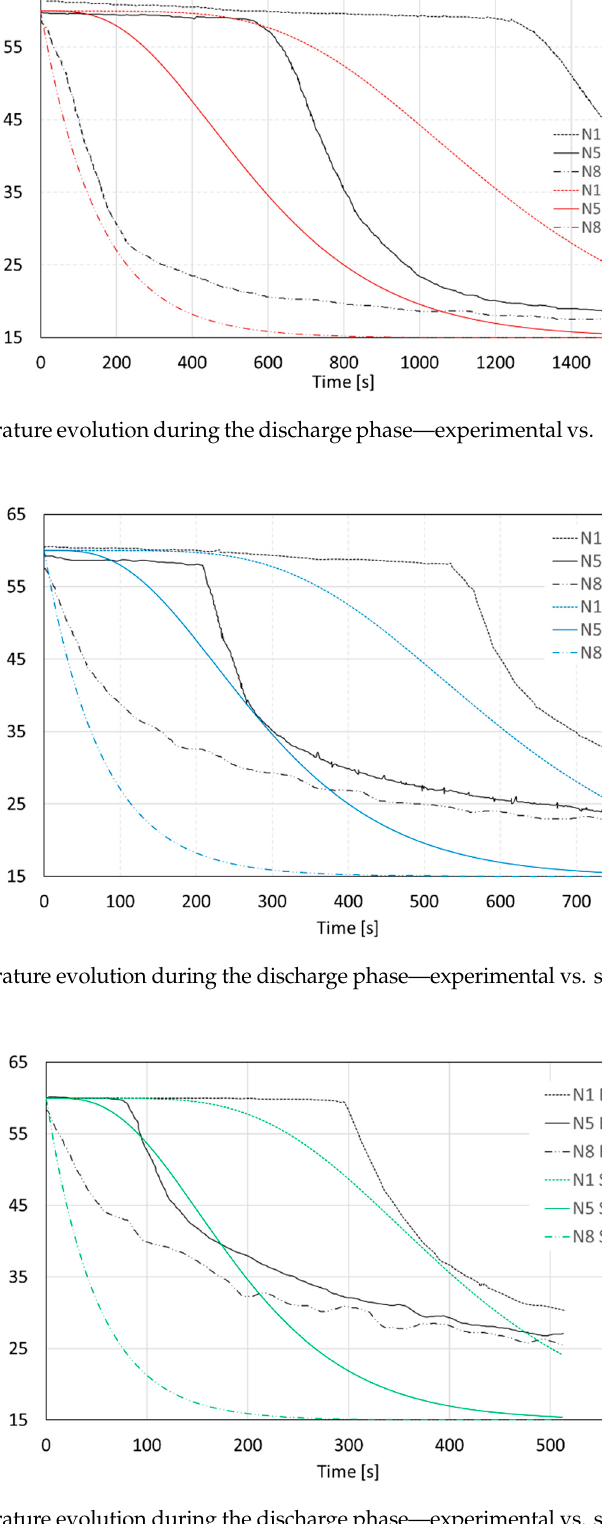
Figure 19. Temperature evolution during the discharge phase—experimental vs. simulated—15 dm 3 /min volume flow rate.